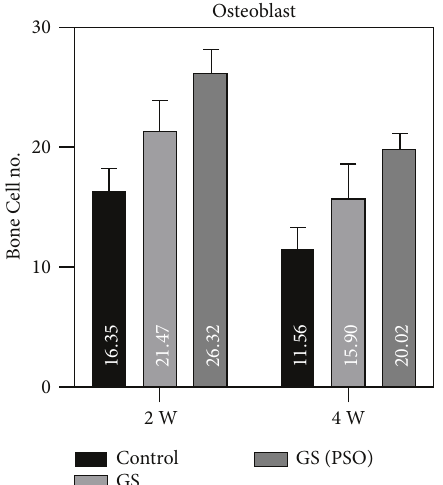
2 W Figure 7: A bar chart representation of the mean and standard deviation of bone cells after 2- and 4-week time intervals for os- teoblast, considering the C, GS, and GS/PSO